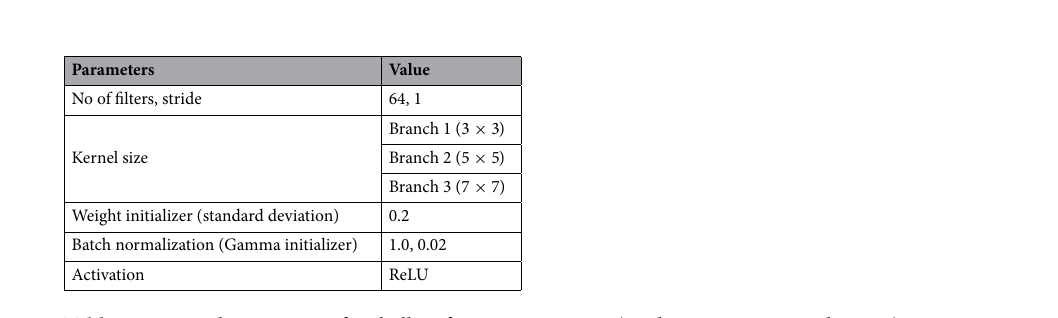
Table 1. Network parameters for shallow features extraction (read in connection with Fig.